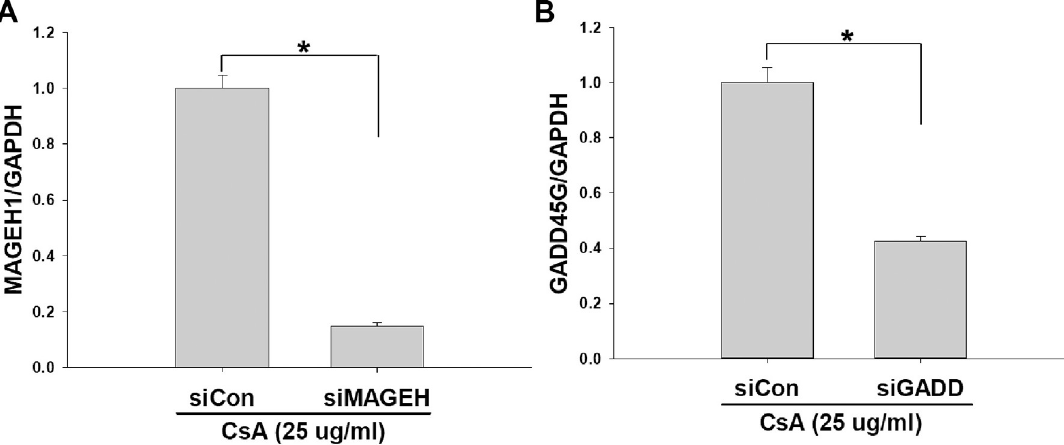
Fig 7. siRNA induced gene silencing in HK-2 cells. HK-2 cell line was transfected with siRNA for 24 h and then treated with 25 μ g/ml CsA for 24 hours to measure mRNA expression using real-time PCR. (A) Transfection with MAGEH1 siRNA (siMAGEH) or control siRNA (siCon). n = 3 each. (B) Transfection with GADD45G siRNA (siGADD) or control siRNA (siCon). n = 3 each. GAPDH served as an internal control. Student’s t-test was used to compare groups. A p value < 0.05 was considered significant. � p < 0.05 between groups.